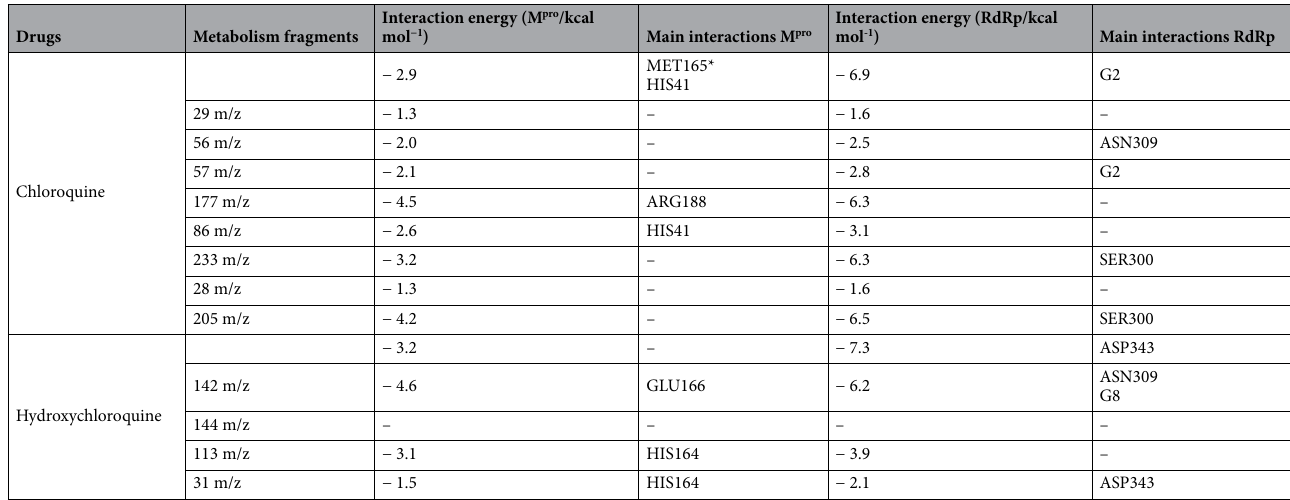
Table 1. Interaction energy (in kcal mol -1 ) of drugs and their metabolism fragments computed through AutoDock Vina program. *Halogen bond-type